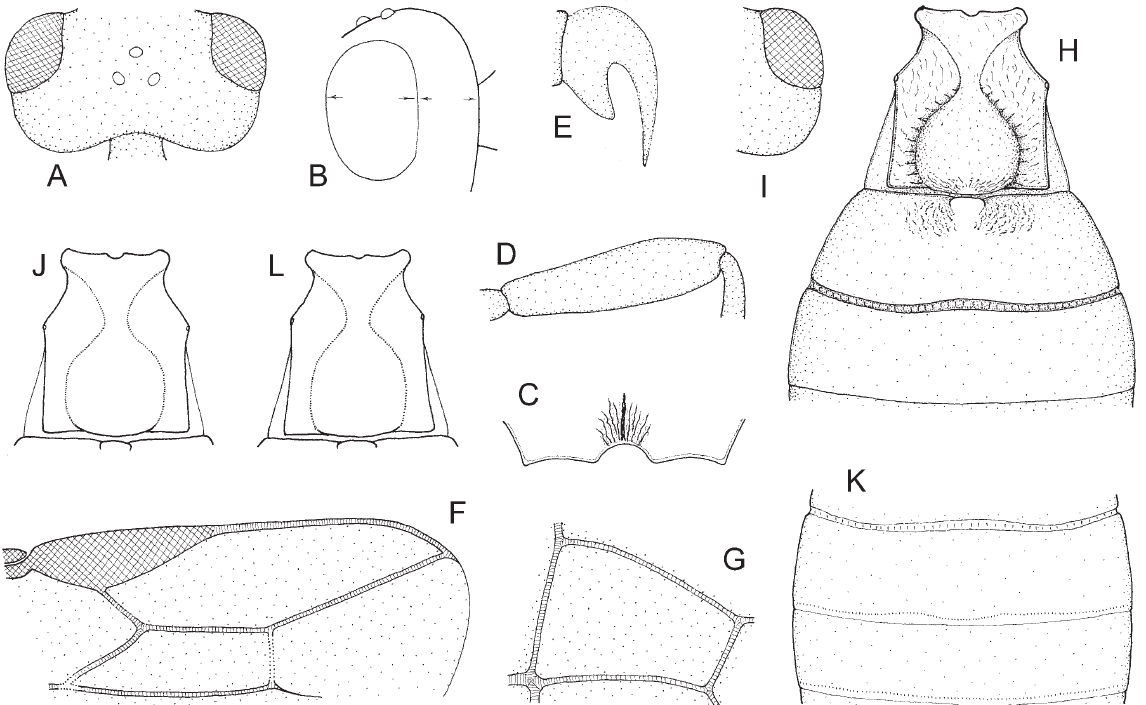
Fig. 27. Bracon ( Glabrobracon ) nigricollis Wesmael, 1838 (A - H, J-L: ♀, I: ♂). A . Head in dorsal view. B . Head in lateral view. C . Posterior third of propodeum. D . Hind femur. E . Claw. F . Distal part of right forewing. G . First discal cell of right forewing. H . Tergites 1-3. I . Right half of head in dorsal view. J . First tergite. K . Tergites 3-4. L . First